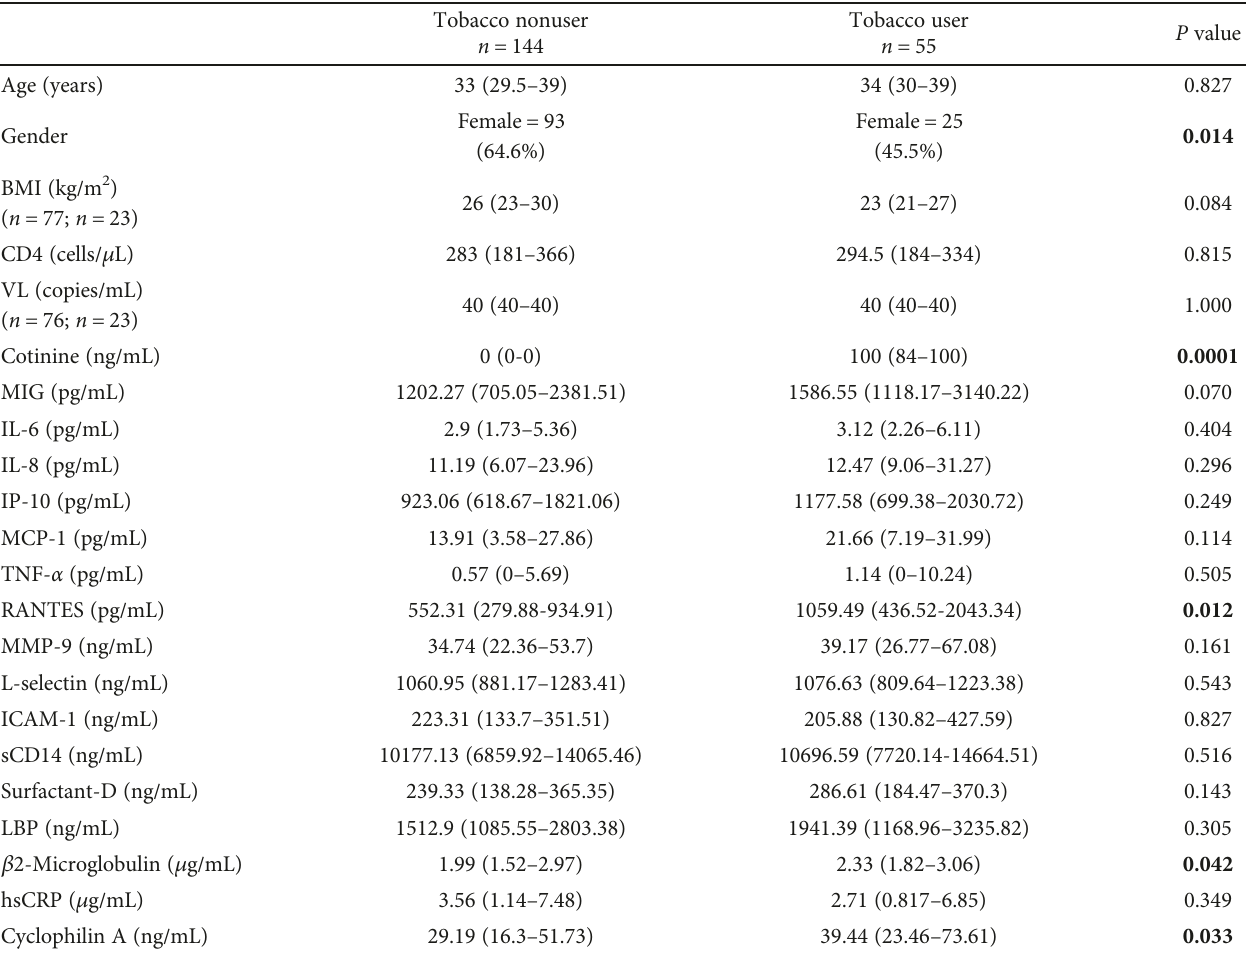
Table 2: Demographic, clinical, and biomarker results according to tobacco